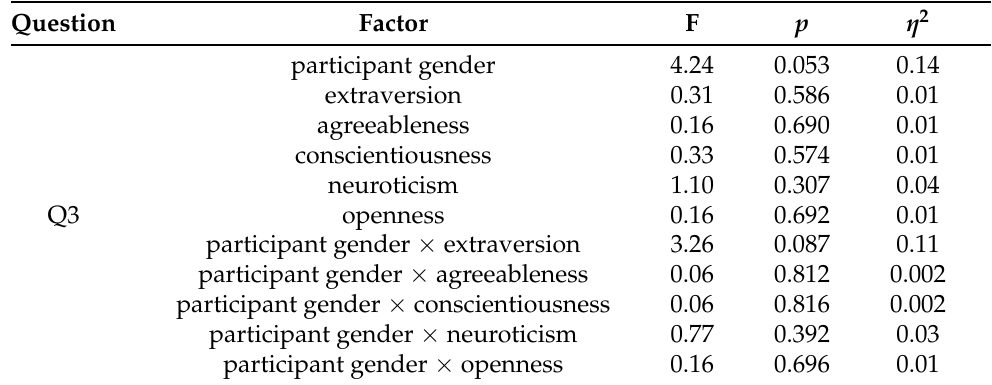
Table A3. GLM analysis of the effect of participants’ personality traits (i.e., extraversion, agreeable- ness, conscientiousness, neuroticism, openness) on their responses to question Q3.